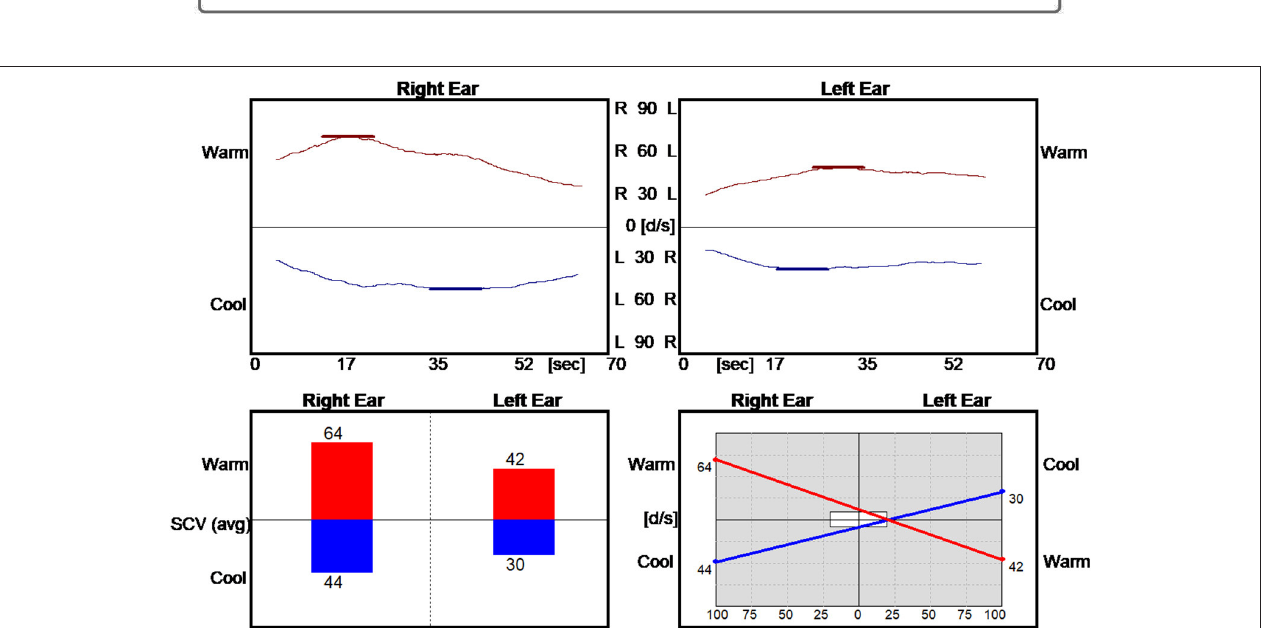
deemed a ‘critical stenosis’. In addition, the left vertebral artery cinched off at the transition between V2-3 at the base of the C2 lateral mass where the vertebral artery turns lateral. A repeat CTA of the head was ordered to examine the cervical